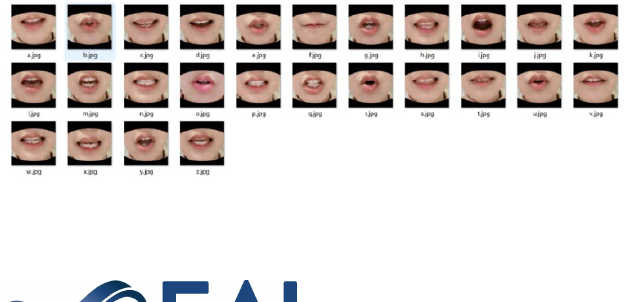
Figure 1. Lip shape in